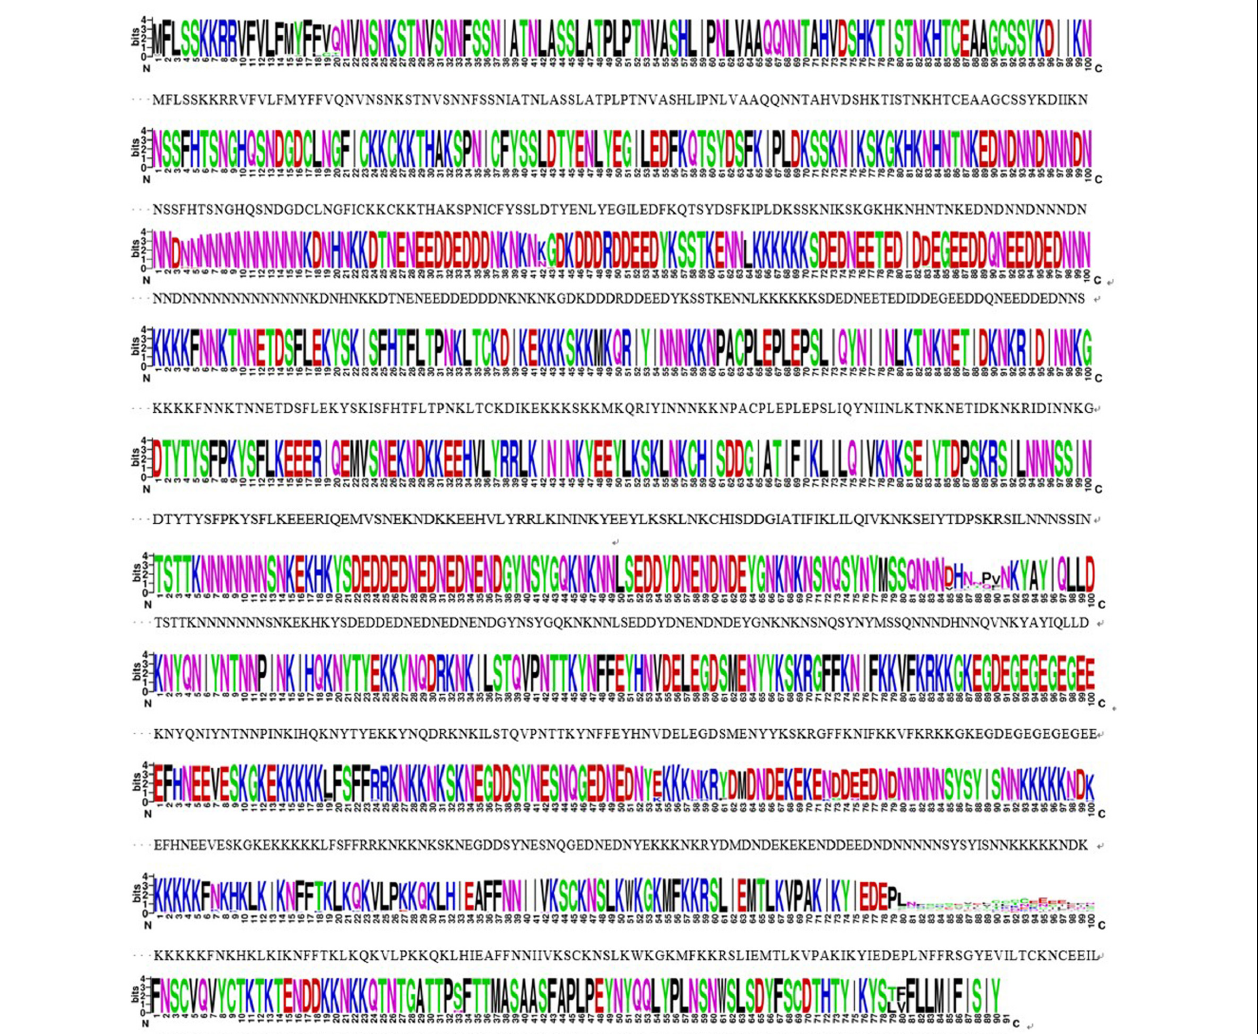
FIGURE 4 | Conservative locus analysis of the PfSRA amino acid sequences defined by WEBLOGO. Each logo consists of stacks of symbols, and each position in the sequence corresponds to stacks of symbols. The height within the stack of each individual amino acid abbreviation indicates its relative frequency at that specific